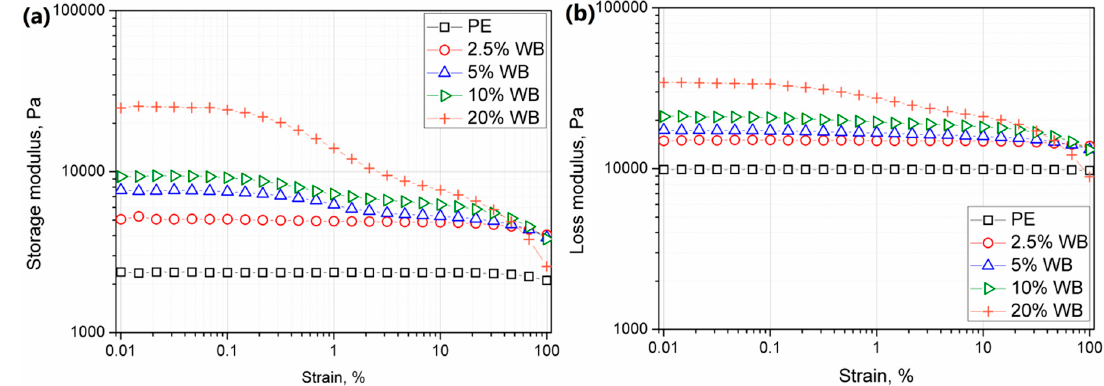
Figure 12. Storage ( a ) and loss ( b ) modulus changes obtained during strain-sweep rheological